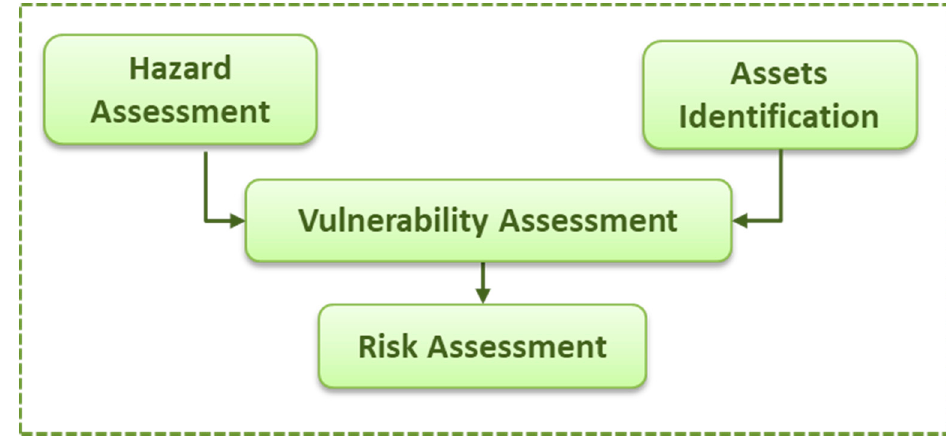
Figure 4. General approach to flood risk assessment for a chosen mitigation strategy.